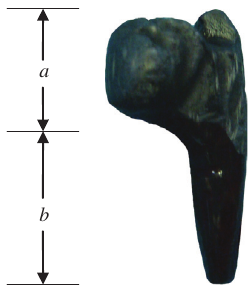
Figure 1 Gross appearance of the implants.